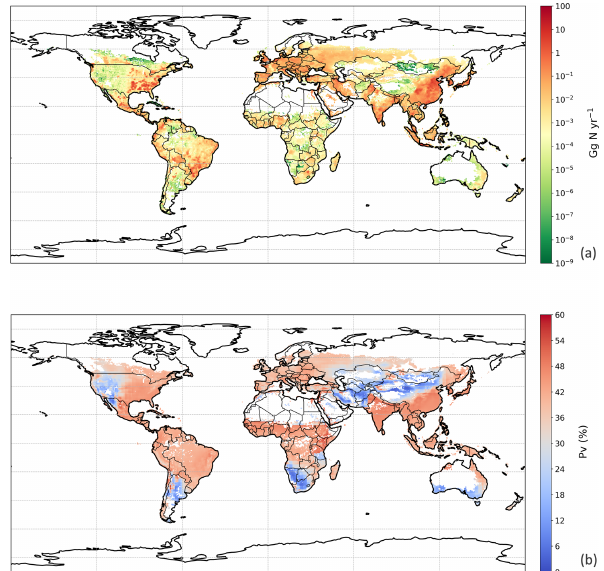
Figure 10. Same as Fig. 9 but for chicken manure application for crops in 2010.